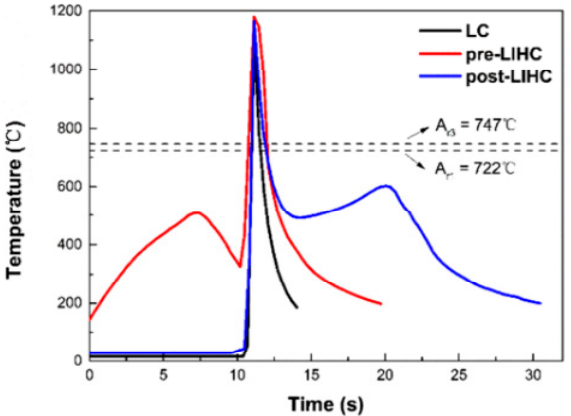
Figure 8. Thermal cycle curves of the heat-affected zones (HAZs) under different technologies (re- printed from Ref. [26], copyright (2019), with permission from Elsevier).